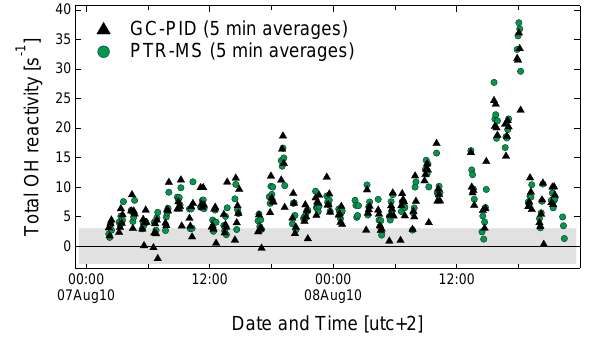
Fig. 10. Direct total OH reactivity measurements in the J¨ulich Plant Atmospheric Chamber (JPAC) for primary boreal tree emissions. The 15min averaged results of the GC-PID (black) show the same trend but a higher variability than the PTR-MS (green) 5min aver- ages. The gray shaded area marks the range of the PTR-MS detec- tion limit (4s − 1 ) and the gray pattern the GC-PID detection limit of 6s − 1 .